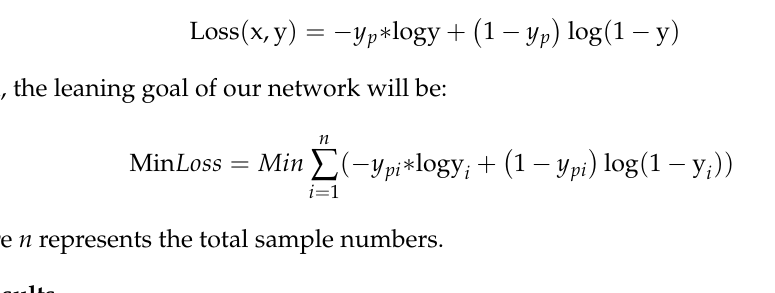
Figure 5. Flowchart of Self-Attention module.